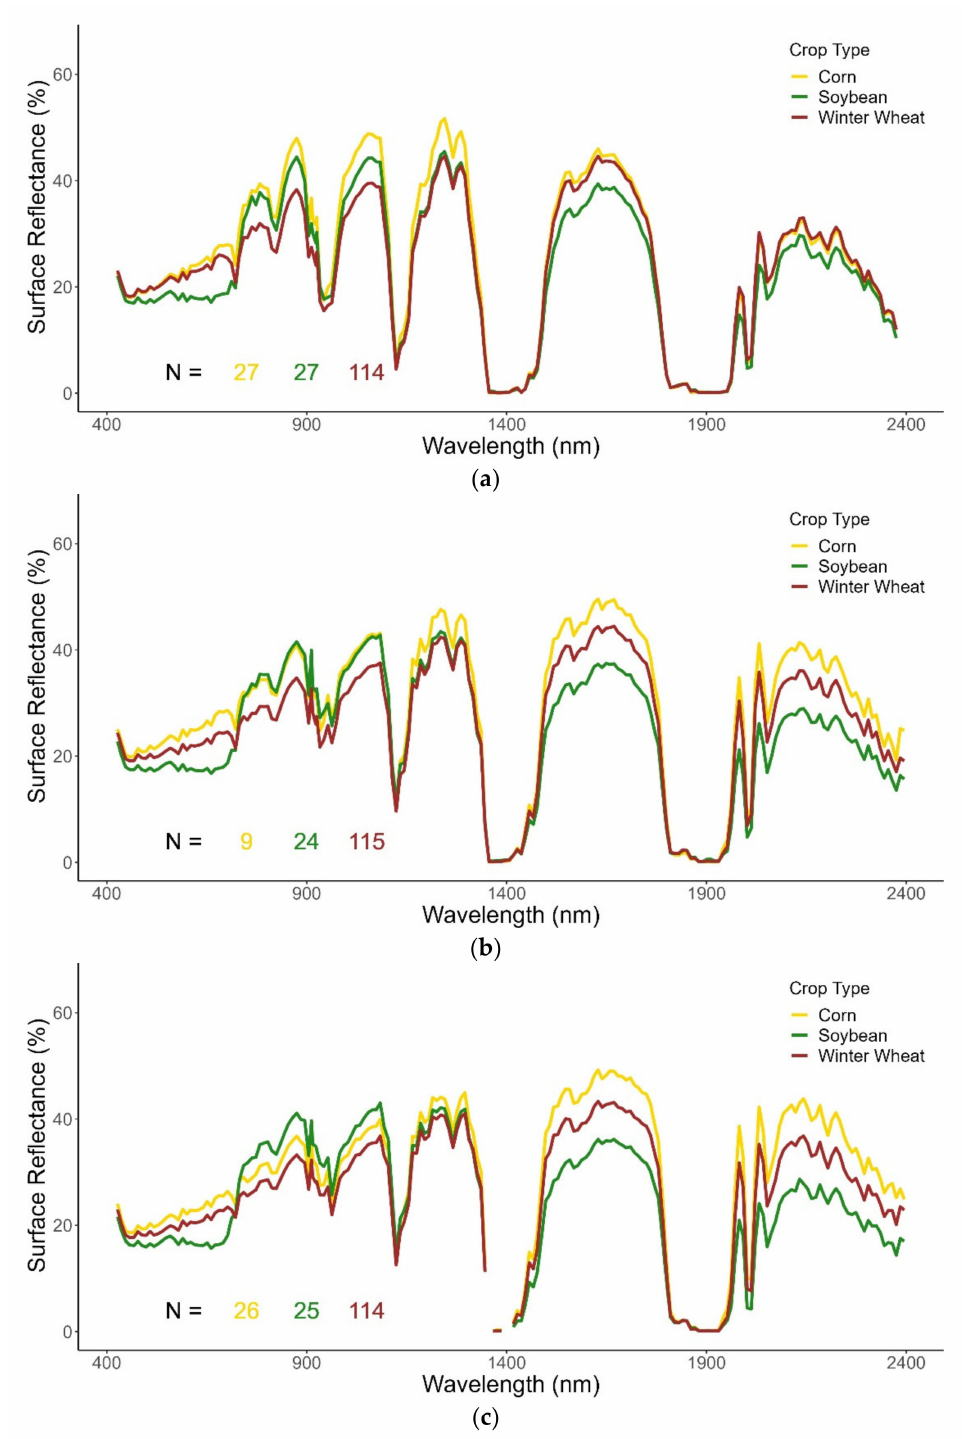
Figure 4. Average Hyperion 2012 (normal year) spectra by crop type for: ( a ) July (Julian Day 200), ( b ) August (Julian Day 234), and ( c ) September (Julian Day 255). N is number of spectra included in the